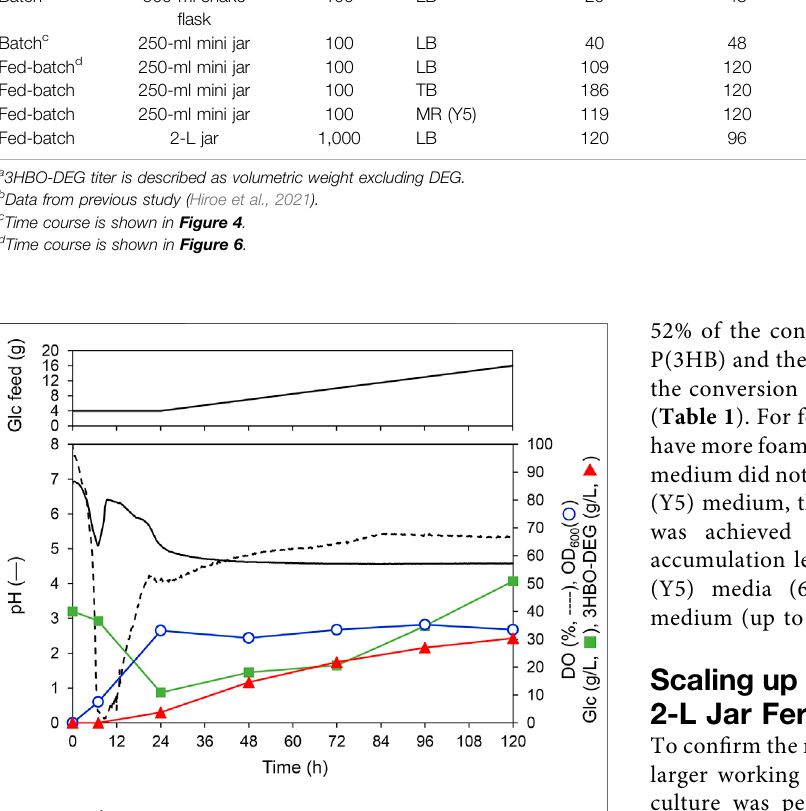
FIGURE 6 | Fed-batch culture of E. coli BW25113 Δ adhE harboring pGEM-